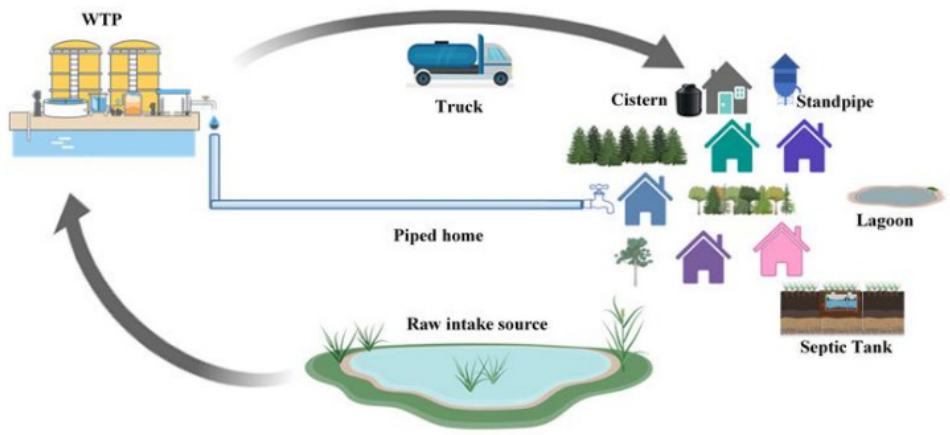
Figure 1. Schematic diagram showing various sampling points in DWDS of two First Nation communities investigated in this study.